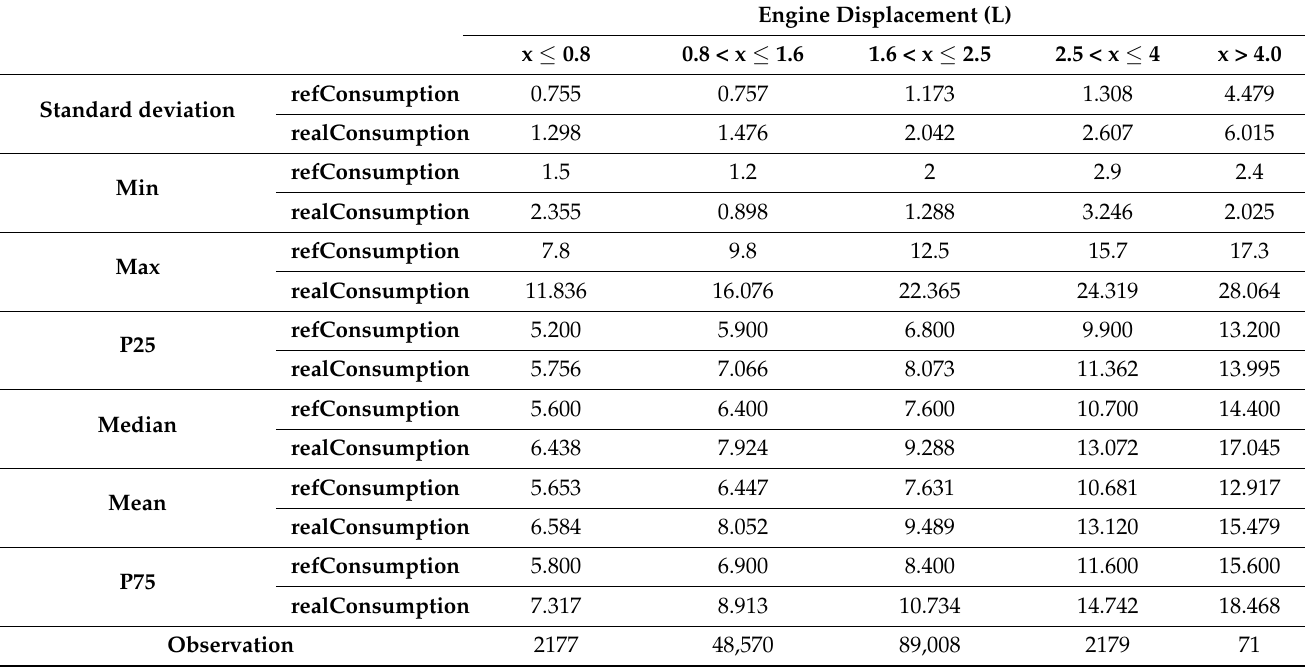
Table 2. Descriptive